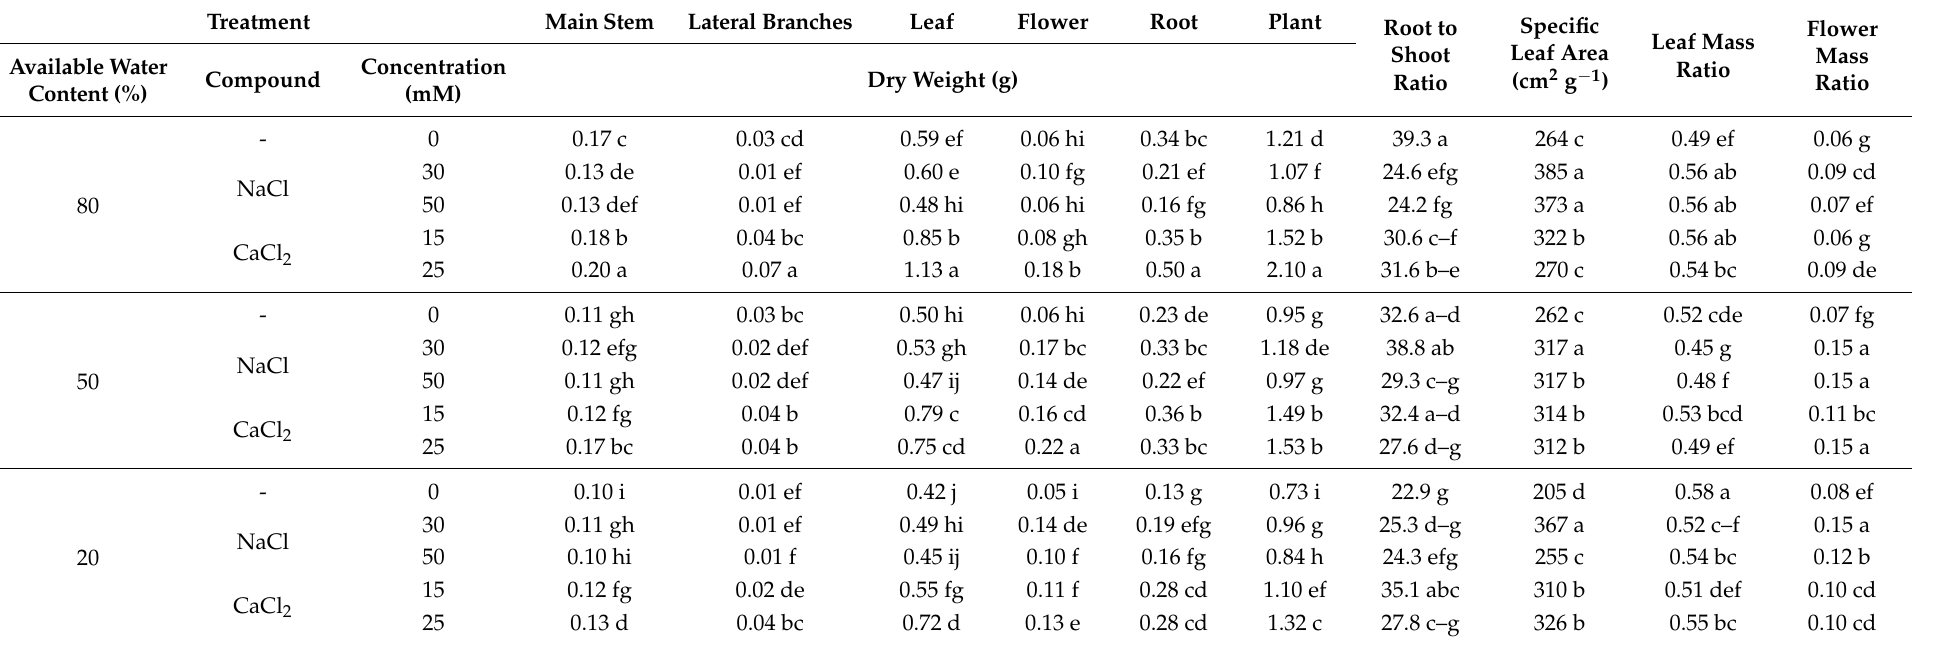
Table 3. Plant growth, biomass allocation and morphology of periwinkle cv. ‘Pacifica XP Really Red’ plants initially receiving NaCl (0, 30 and 50 mM) or CaCl 2 (15 and 25 mM) via irrigation (five applications at 3 d intervals), and subsequently exposed to different watering levels (80, 50 and 20% available water content) during cultivation. At first application, plants were at the four-leaf stage. Means followed by different letters indicate significant differences ( p = 0.05; comparison in columns). Values are the mean of four replications. STI, stress tolerance index, WUE, water use